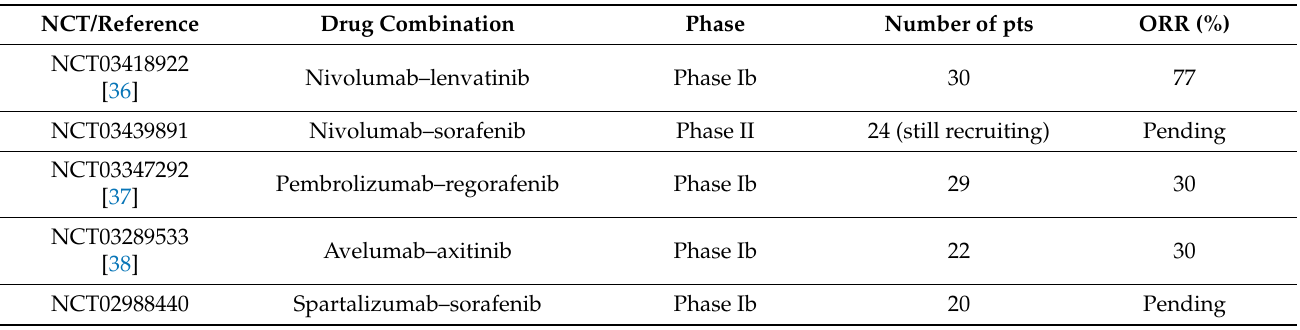
Table 3. Phase I/II studies of immune checkpoint inhibitors and antiangiogenic tyrosine kinase inhibitors in advanced hepatocellular